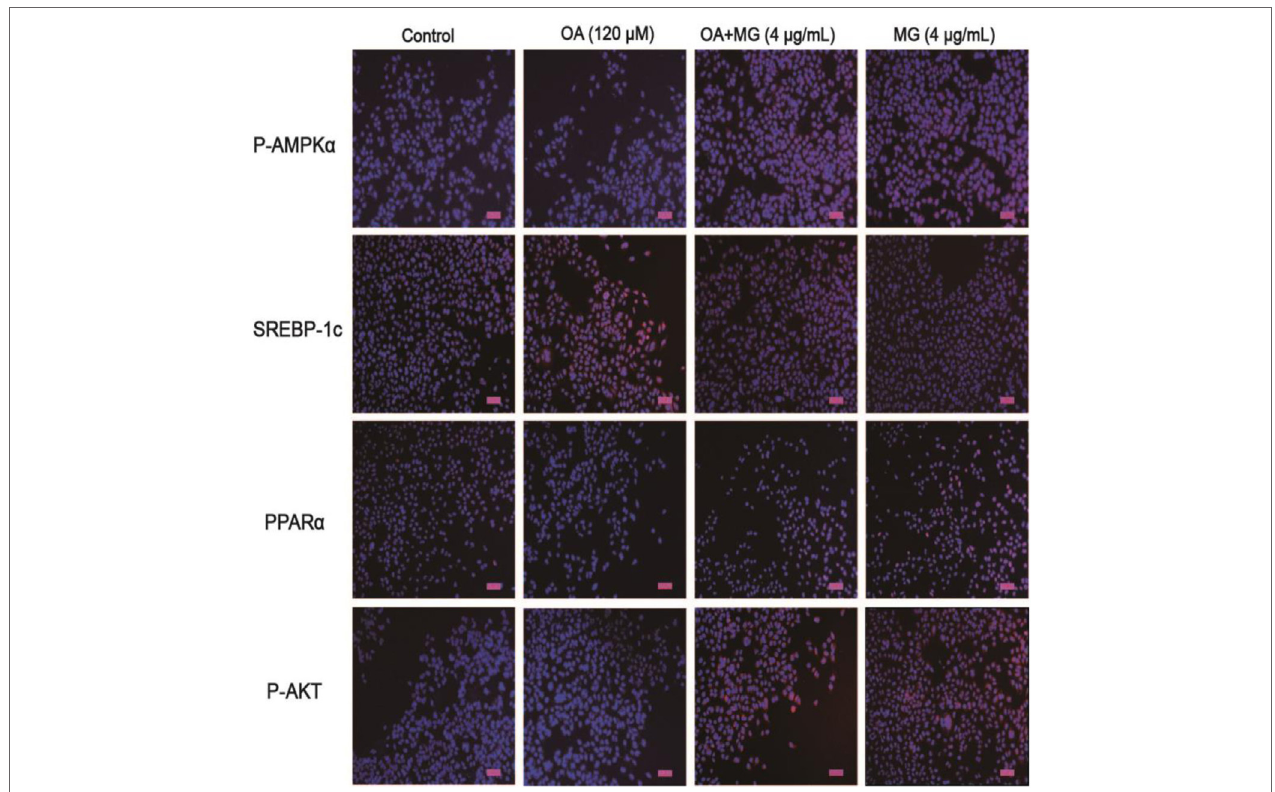
FigUre 5 | Effect of magnolol (MG) on the expression of proteins related to hepatic steatosis in HepG2 cells. Cells were exposed to MG (4 µg/mL) with or without oleic acid (OA) (120 µM) for up to 24 h. Afterward, immunofluorescence for peroxisome proliferator-activated receptor α (PPAR α ), SREBP-1c, P-AKT, and P-AMPK α (red) and the nuclear dye DAPI (blue), and scale bars represent 100 µm. All data are expressed as the mean ± SD of three independent